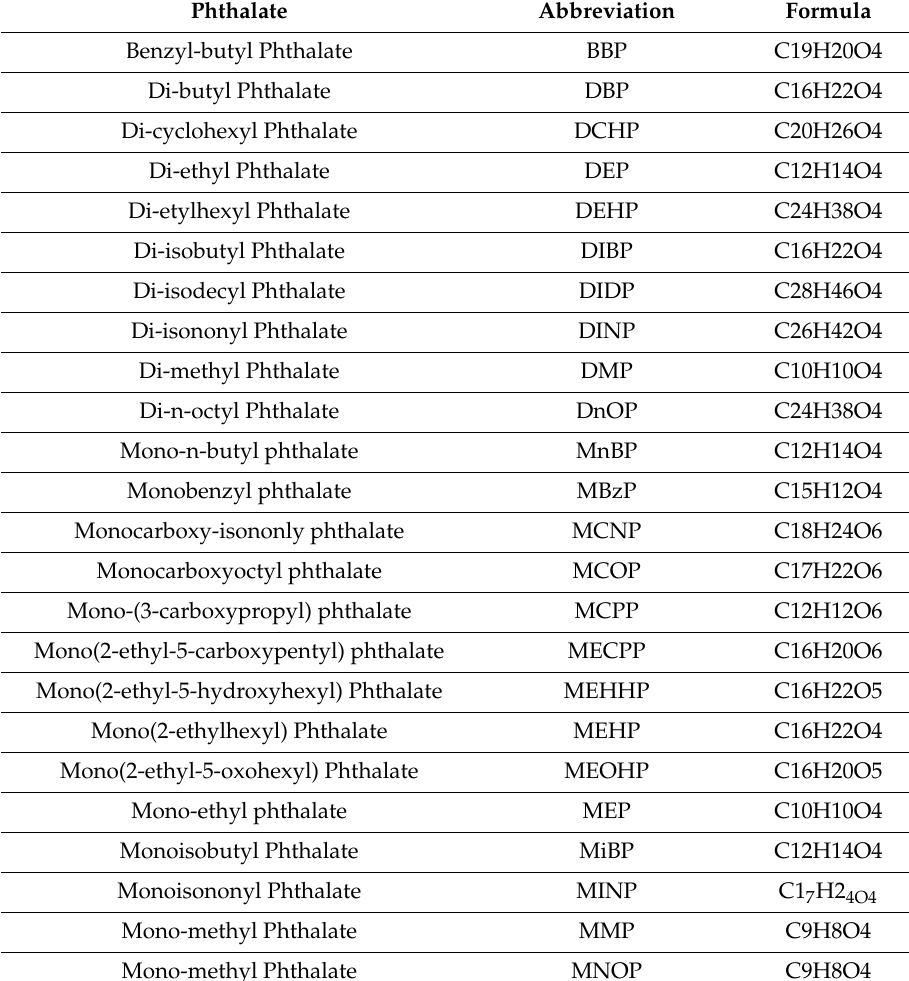
Table 2. List of abbreviations of the most common parent phthalates and their